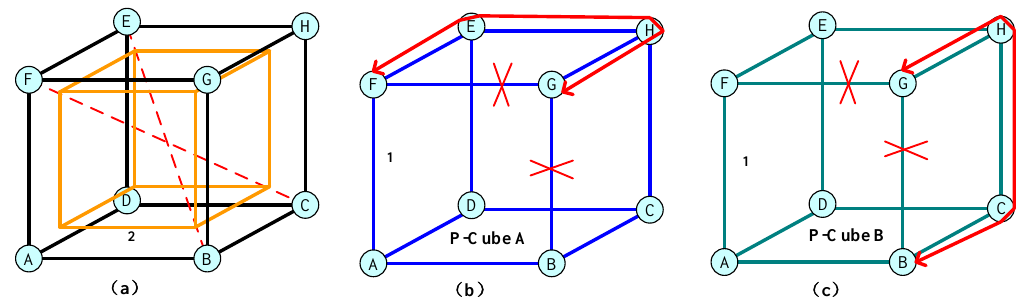
Figure 6. The p-cube scheme: ( a ) p-cube configuration; ( b ) traffic recovery in p-cube A; ( c ) traffic recovery in p-cube B [96].